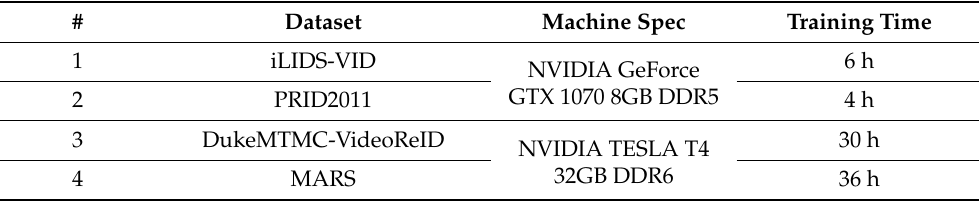
Table 1. Summary of implementation training